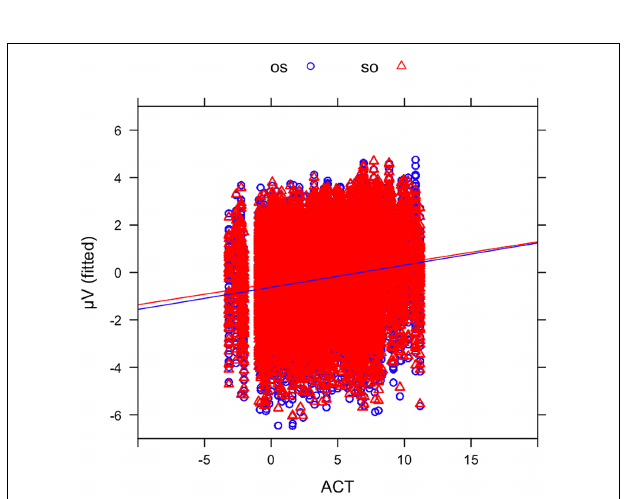
FIGURE 6 | Mean voltages in the N400 time window at the position of the critical noun phrase plotted against actorhood potential (ACT). Sentences in object initial order (OS) are shown in blue circles and sentences in subject initial order (SO) in red triangles.